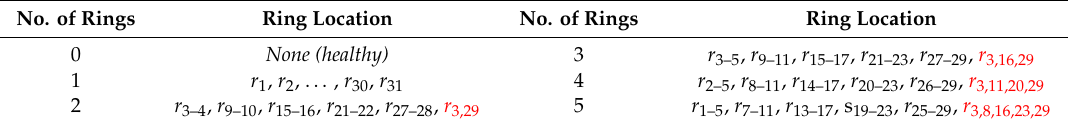
Table 2. Number and location of sheath rubber rings installed on the solenoid. Rings are separated on the bobbin for the red-colored rings.